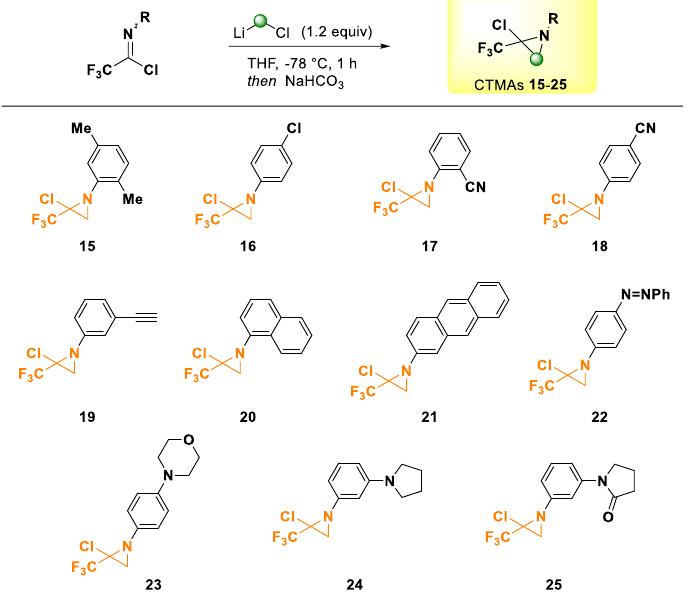
Scheme 1. Chemical structure of chloro(trifluoromethyl)aziridines (CTMAs, 15 – 25